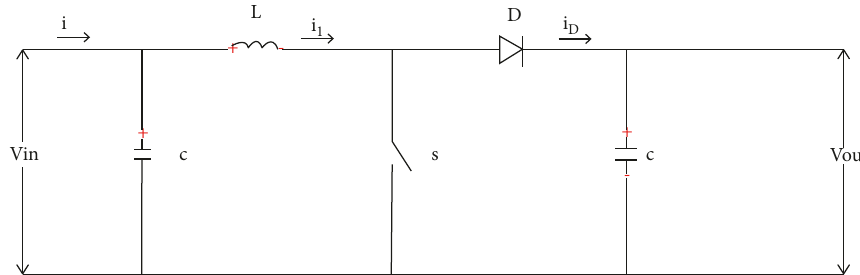
Figure 3: DC-DC boost